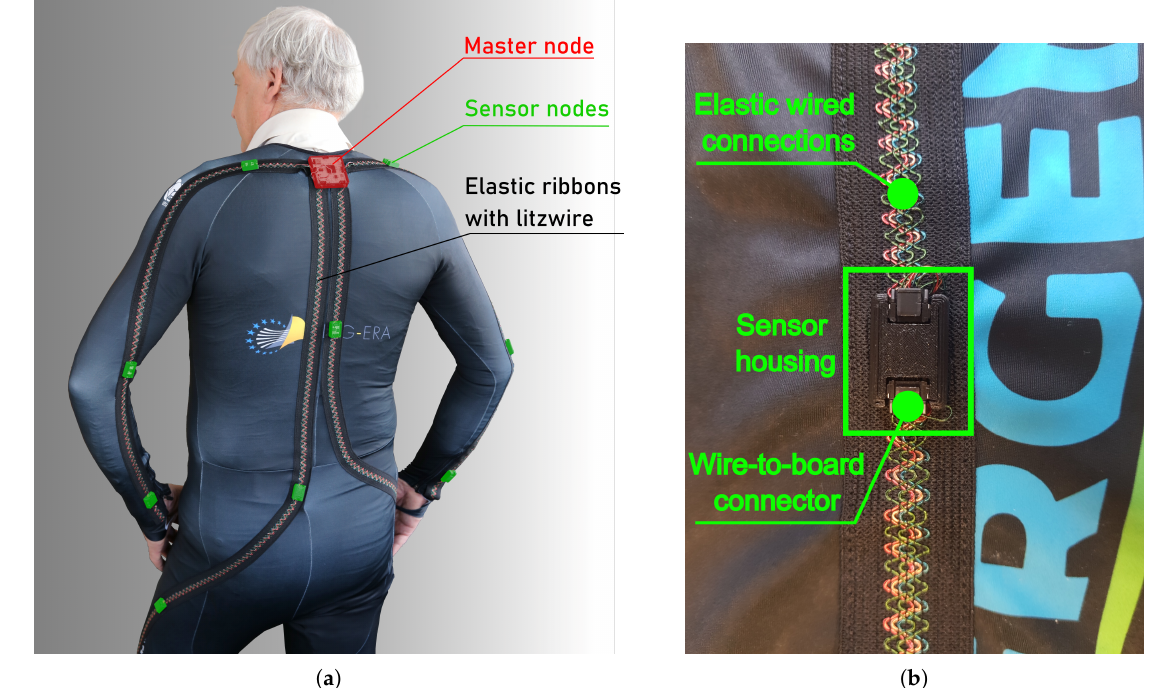
Figure 8. Experimental setup. ( a ) The sensor clothing with multi-branch IMU sensor network. ( b ) The custom 3D-printed housing used for sensor